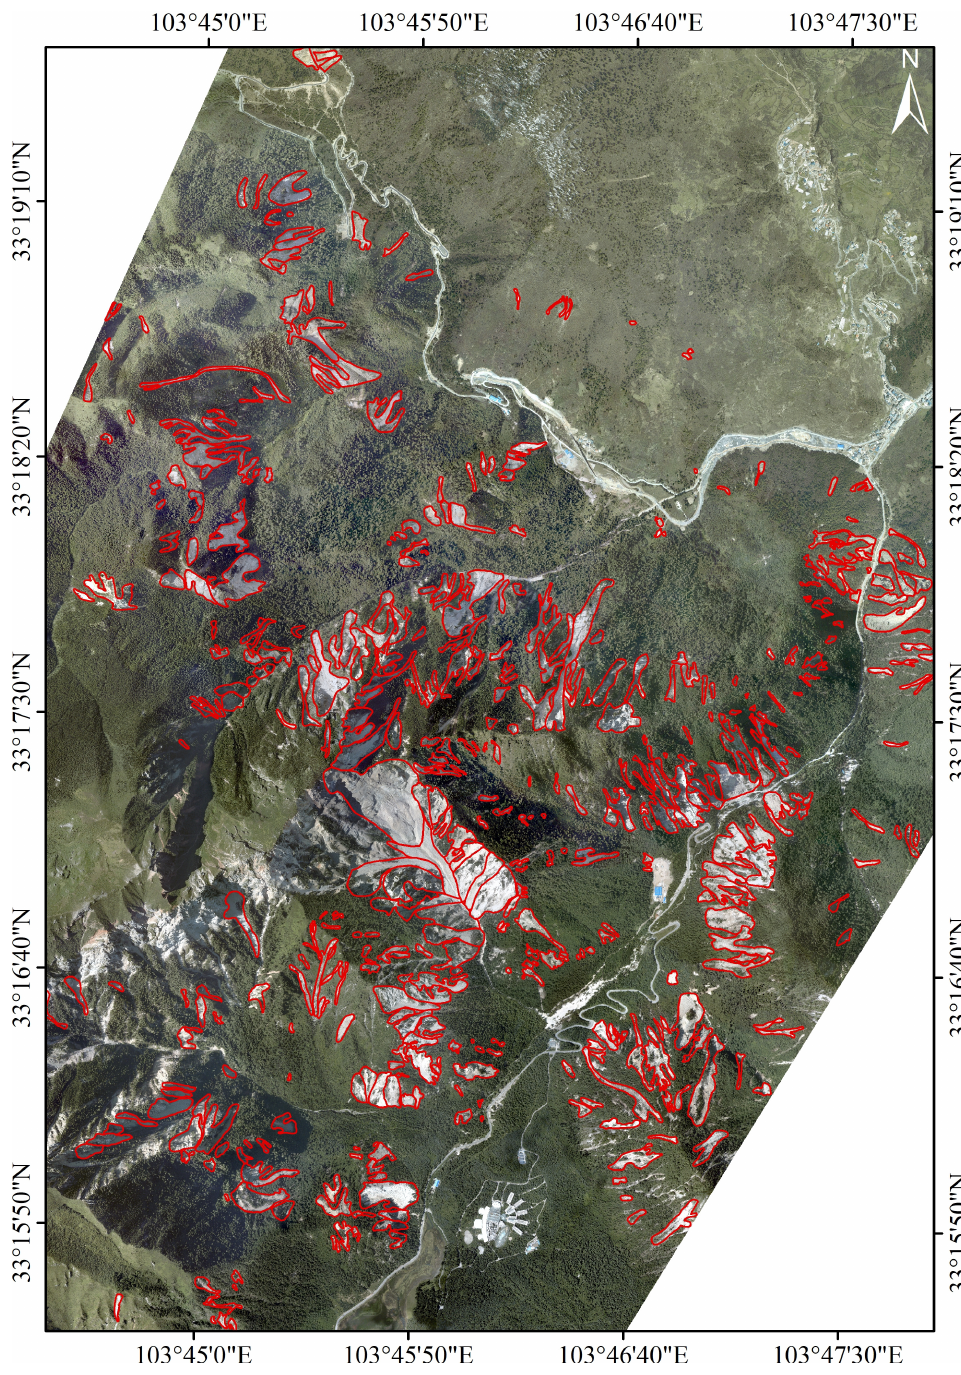
Figure 6. Visualization results of the manually annotated landslide labels. Red lines are the boundaries of